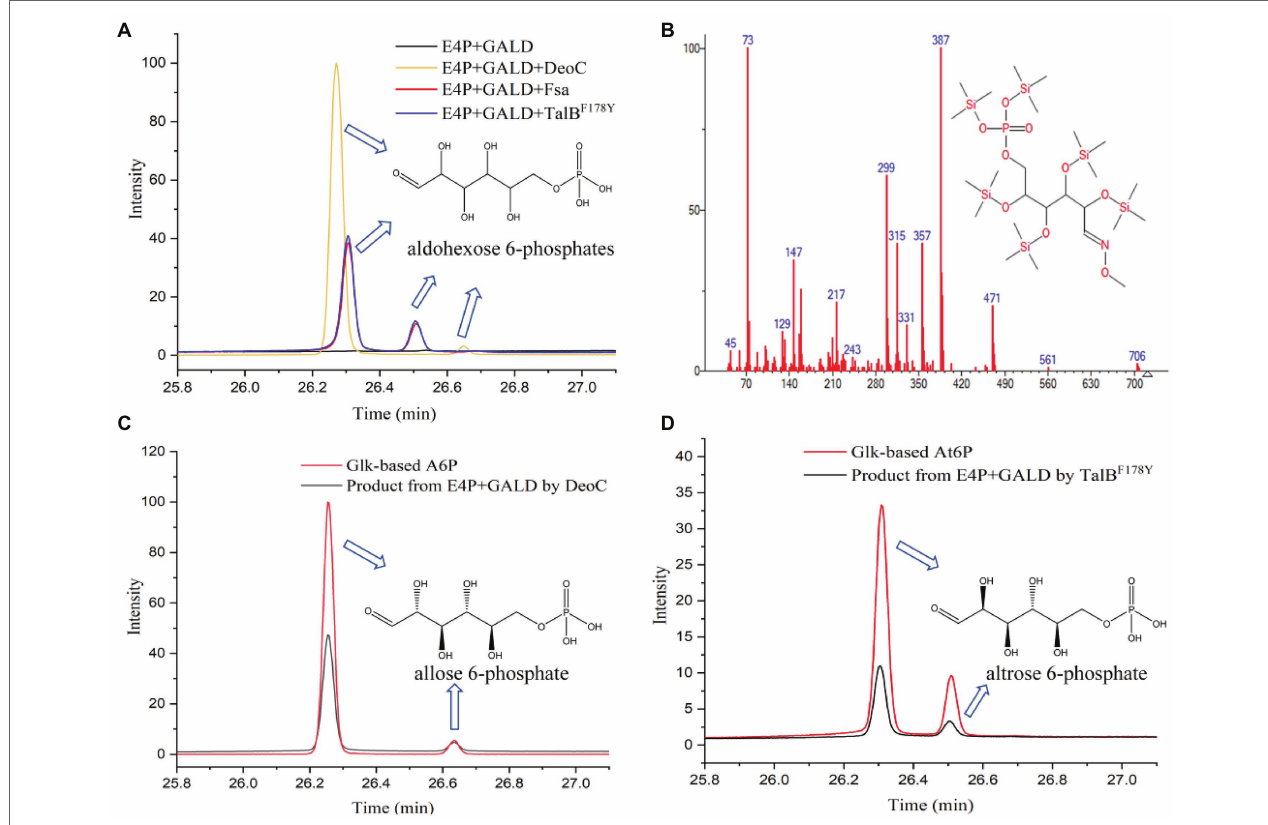
FIGURE 5 | Identification of aldol reaction products by GC-TOFMS. (A) The products of the condensation of GALD with E4P by TalB F178Y , Fsa, and DeoC. (B) Fragment distributions of peaks with retention times of 26.307, 26.274, 26.511, and 26.650 min. (C) Glk-based A6P and the product from E4P and GALD catalyzed by DeoC. (D) Glk-based At6P and product from E4P and GALD catalyzed by TalB F178Y .